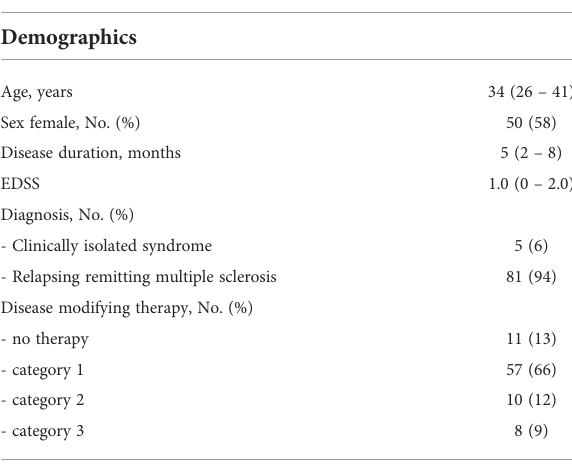
TABLE 2 Clinical characteristics of the clinical